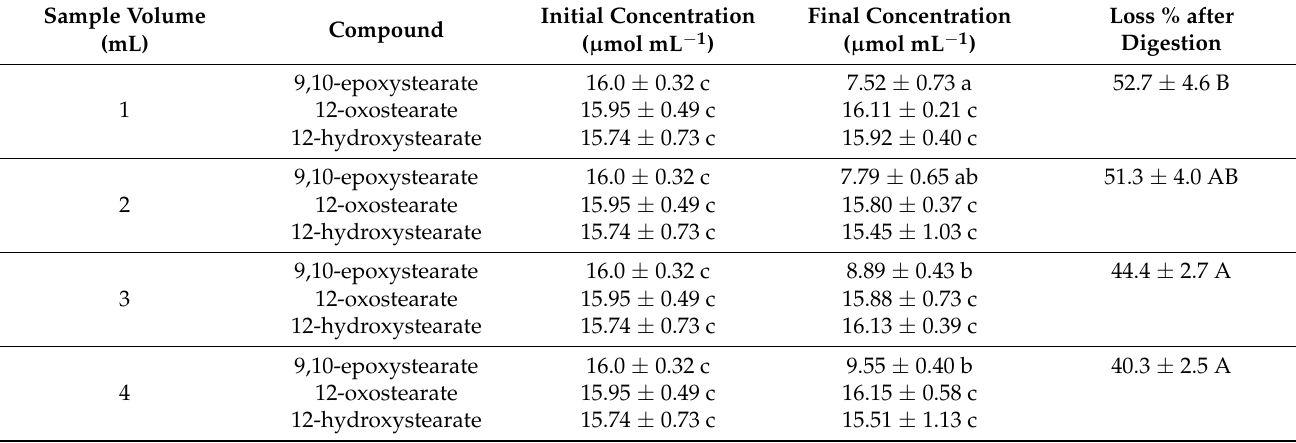
Table 1. Quantitation of methyl 9,10-epoxystearate, methyl 12-oxostearate and methyl 12-hydroxystearate in an equimolar mixture, before and after simulated gastric